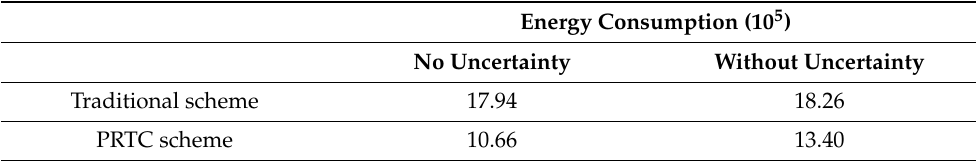
Table 6. Performance of the traditional scheme and the PRTC scheme in energy consumption under uncertainty. Energy Consumption (10 5 ) No Uncertainty Without Uncertainty Traditional scheme